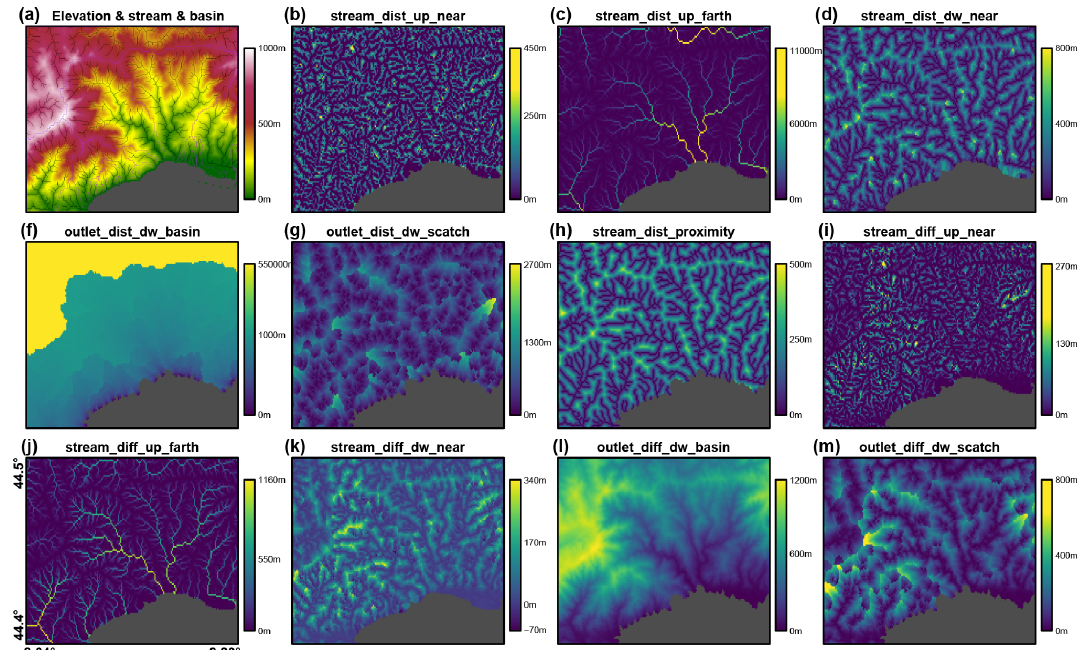
Figure 12. Map (a) shows the stream channels and drainage basins derived from the elevation layer. Maps (b) – (m) show, for the same area, the distance and elevation difference attributes of each land grid cell to the stream channels, outlets, or stream nodes using the r.stream.distance GRASS GIS module. The panel letters correspond to those in Table 4.